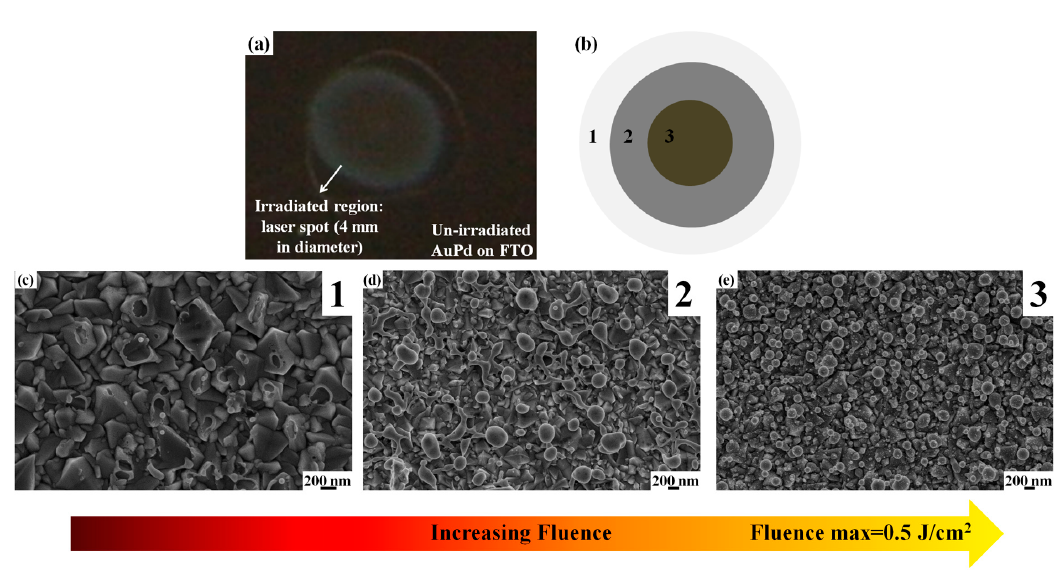
Figure 5. ( a ) Optical photo reporting an example of the laser spot as obtained by irradiating the 29.2 nm-thick AuPd film deposited on the textured FTO (substrate B). As pictured in ( b ), roughly three anular regions can be identified close to the center of the spot and corresponding to an increase of the laser fluence from region 1 to region 3, whereas the maximum laser fluence of 0.5 J/cm 2 is obtained in region 3. ( c – e ) report representative SEM images of the sample surface acquired in region 1 (( c ), at a distance >600 μ m from the spot center), region 2 (( d ), at a distance between 300 and 600 μ m from the spot center), and region 3 (( e ), at a distance lower than 300 μ m from the spot center): this sequence of images clearly shows the dewetting process of the AuPd film.